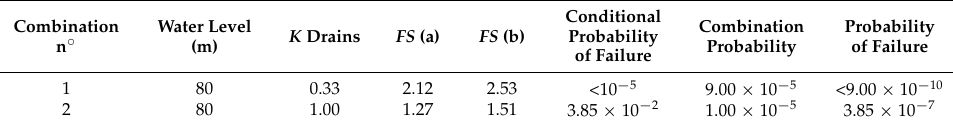
Table 10. Approach II. Results for n = 15.